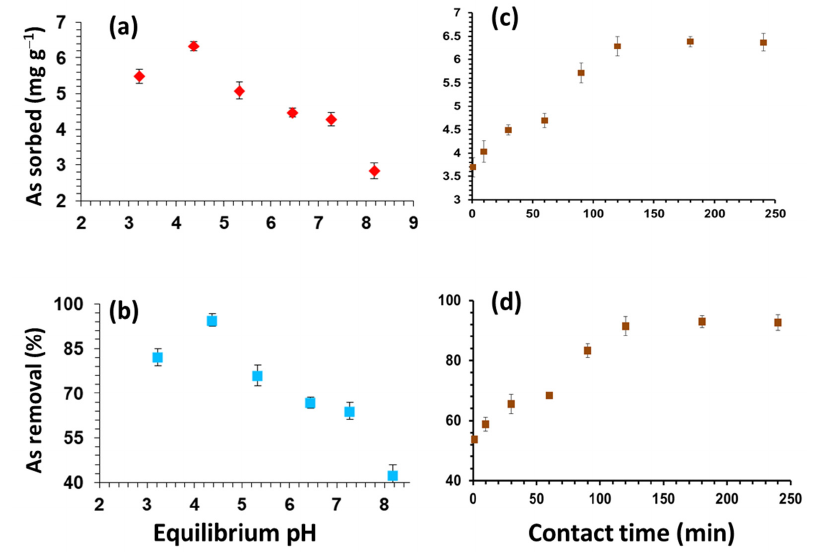
Figure 1. Adsorption of As(V) as a function of pH ( a , b ) and contact time ( c , d ) in